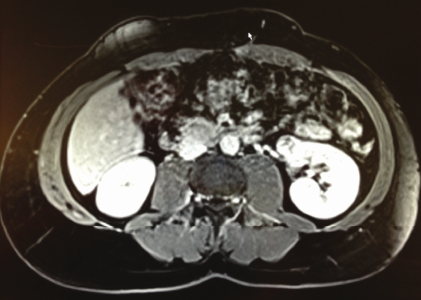
Figure 4: Axial MR image of a 34-year-old male who presented due to an incidentally diagnosed left renal enhancing mass. Maximal tumor diameter was 2.5 cm and R.E.N.A.L. score was 7. He was managed by clamped RANSS. Histopathologic examination of the excised specimen revealed Fuhrman grade 3, pT1a, and clear cell